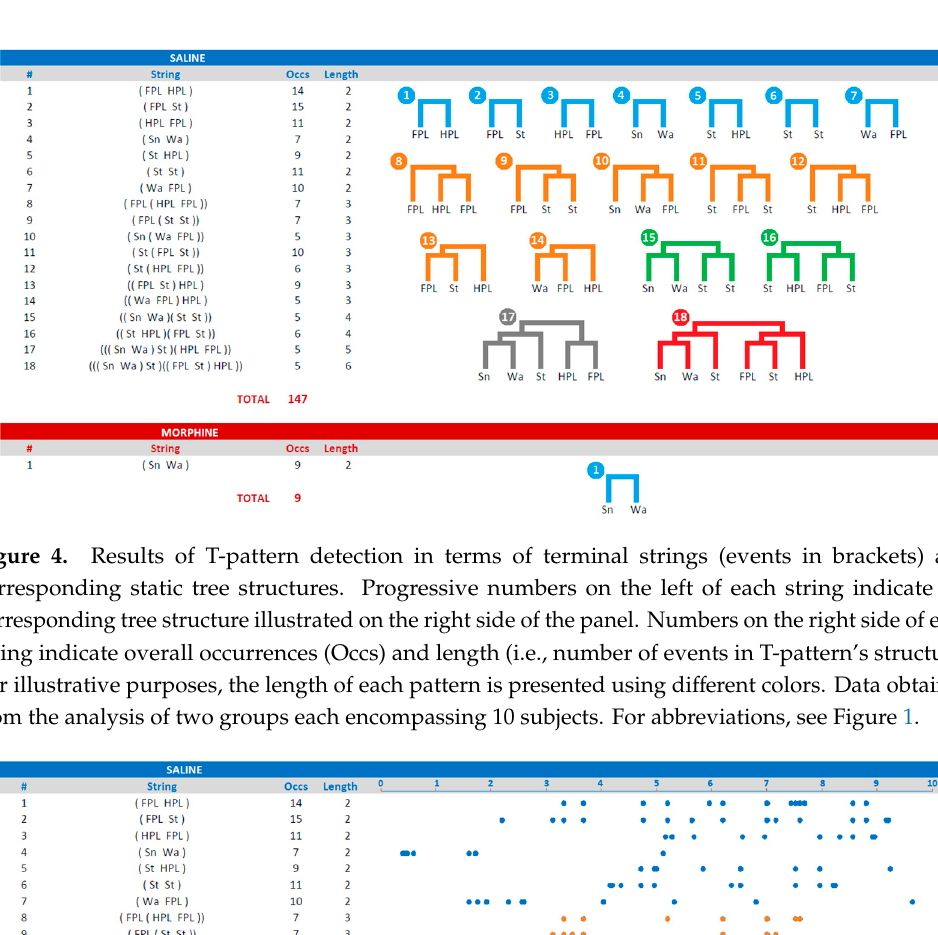
Figure 4. Results of T-pattern detection in terms of terminal strings (events in brackets) and corresponding static tree structures. Progressive numbers on the left of each string indicate the corresponding tree structure illustrated on the right side of the panel. Numbers on the right side of each string indicate overall occurrences (Occs) and length (i.e., number of events in T-pattern’s structure). For illustrative purposes, the length of each pattern is presented using different colors. Data obtained from the analysis of two groups each encompassing 10 subjects. For abbreviations, see Figure 1.